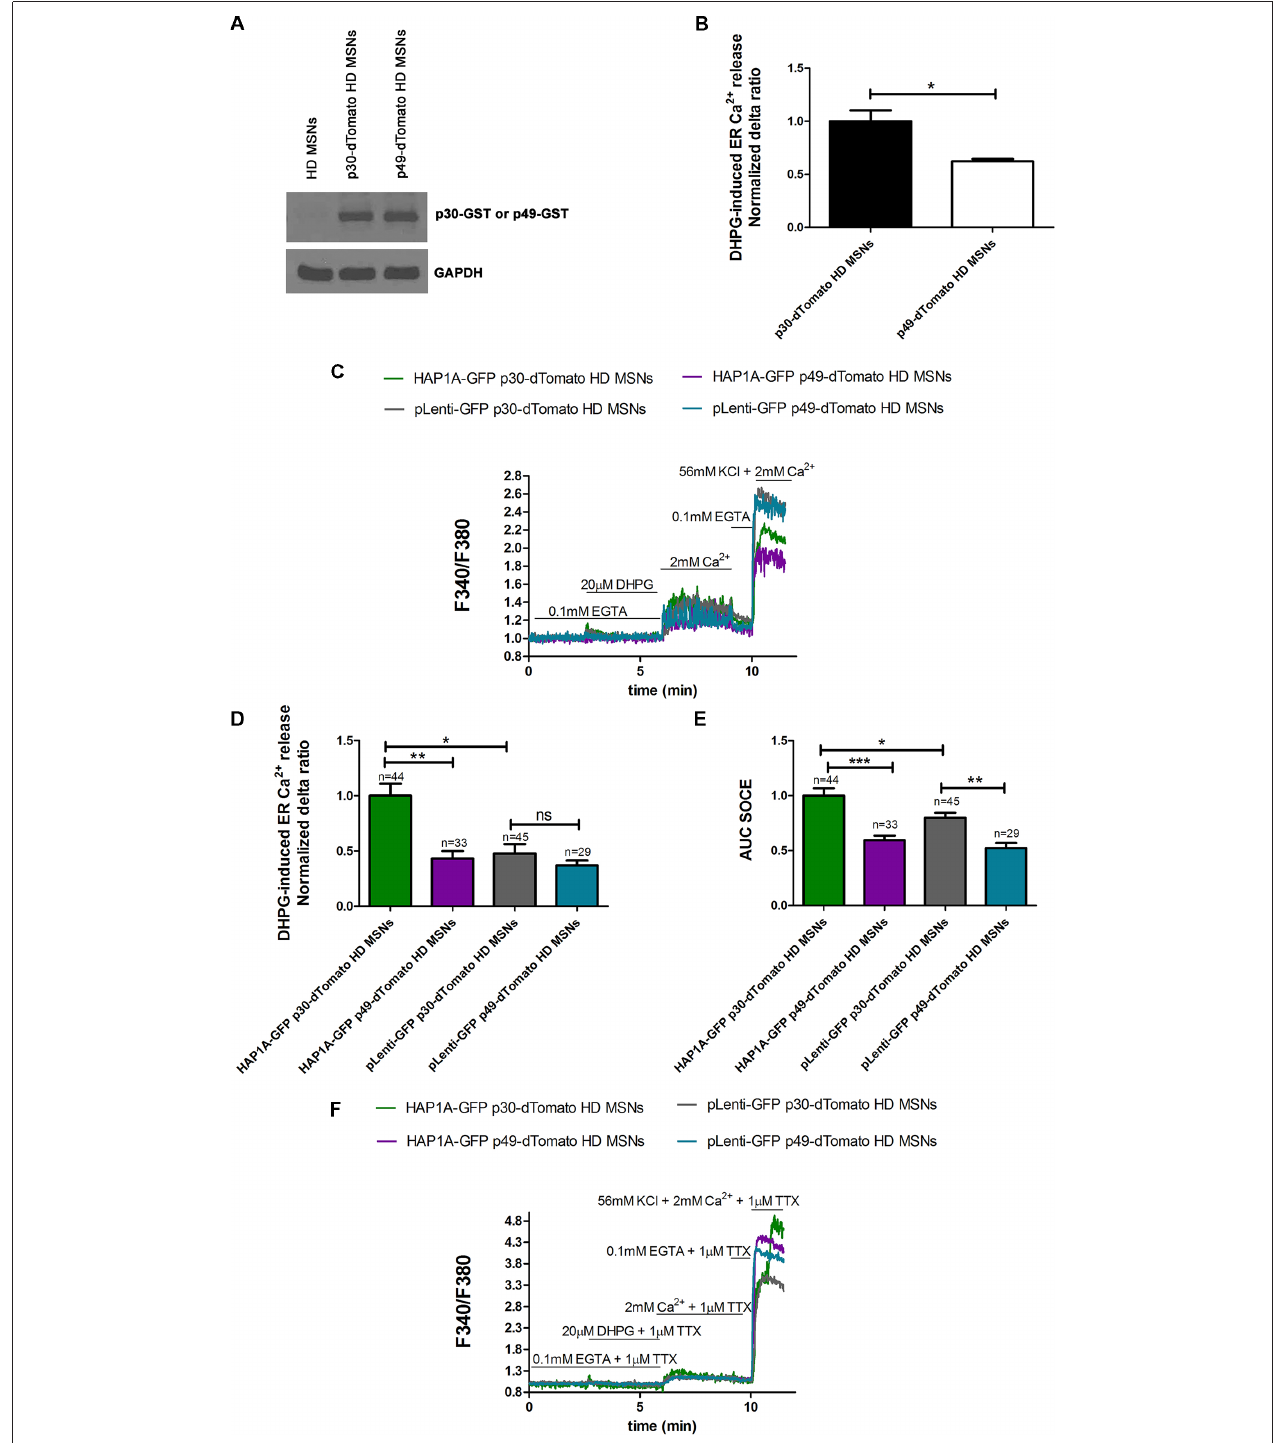
FIGURE 6 | Effect of inositol-(1,4,5)triphosphate (IP 3 ) sponge inhibitor on Ca 2 + signaling in MSNs that overexpress HAP1A. (A) Immunoblots of YAC128 MSN cultures that overexpressed the glutathione S -transferase (GST)-tagged IP 3 R1 ligand binding region (226–604 amino acid region) with a point mutation (R441Q: m49) cloned into the pUltra-Chili vector, indicated as p49-GST, and the negative control with a point mutation (K508A: m30), indicated as p30-GST cloned into the pUltra-Chili vector or control (non-transduced) MSNs. MSN cultures on DIV14 from YAC128 mice that overexpressed p49-dTomato and p30-dTomato as an IP 3 sponge and control respectively were loaded with the Ca 2 + indicator Fura-2AM and incubated in Ca 2 + -free medium. Ca 2 + release from the ER was induced by